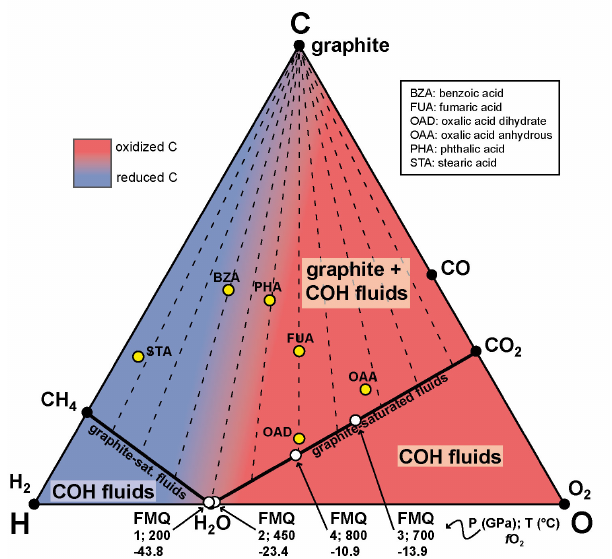
Figure 1. Ternary C–O–H diagram. Black dots: main COH volatile species; yellow dots: organic compounds employed in the literature to investigate COH fluids; white dots: COH volatile composition at oxygen fugacity conditions fixed by the fayalite–magnetite–quartz (FMQ) buffer at fixed pressure and temperature. Oxygen fugacity values are reported as log f O 2